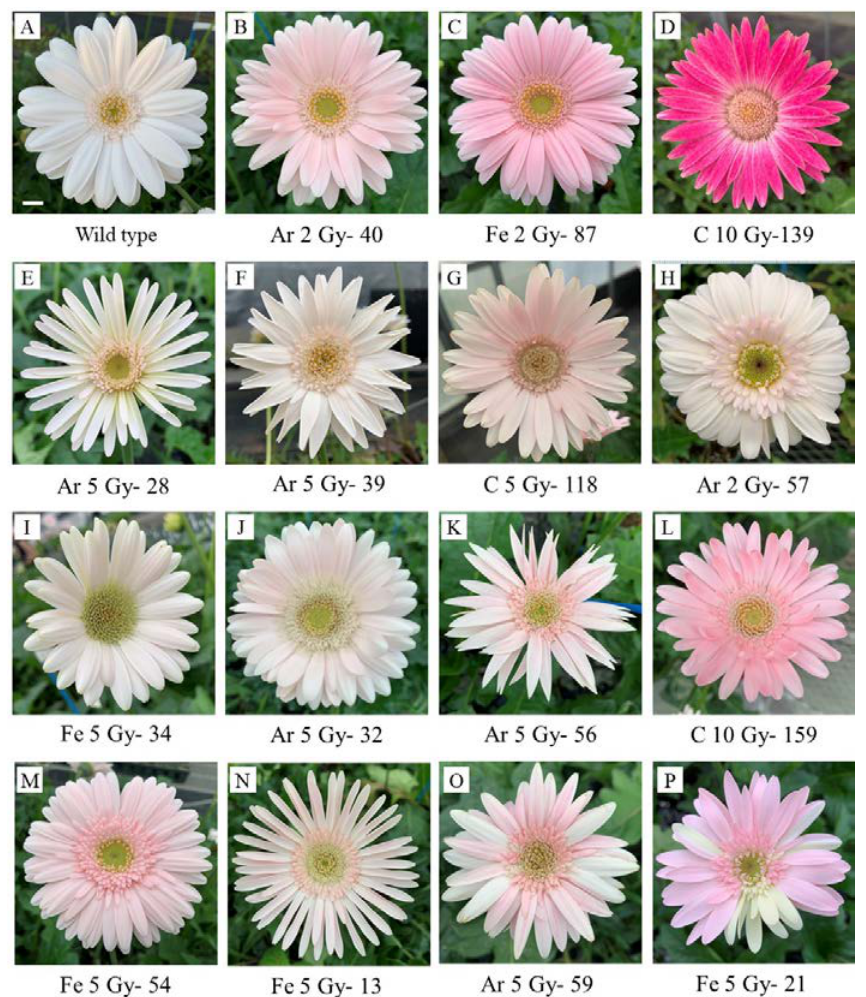
Figure 4. Characteristics of trait/morphological mutations obtained by ion beam irradiation. ( A ) Wild type, ( B – D ) flower color, ( E ) petal slender, ( F ) petal sword, ( G ) receive shape, ( H ) semidouble, ( I , J ) male sterile, ( K ) flower color/petal slender, ( L ) flower color/receive shape, ( M ) flower color/semidouble, ( N ) petal slender/male sterile, and ( O , P ) chimeric mutation. Scale bar represents 1 cm. All the numbers represent in the figure indicate line number in the irradiated plants.